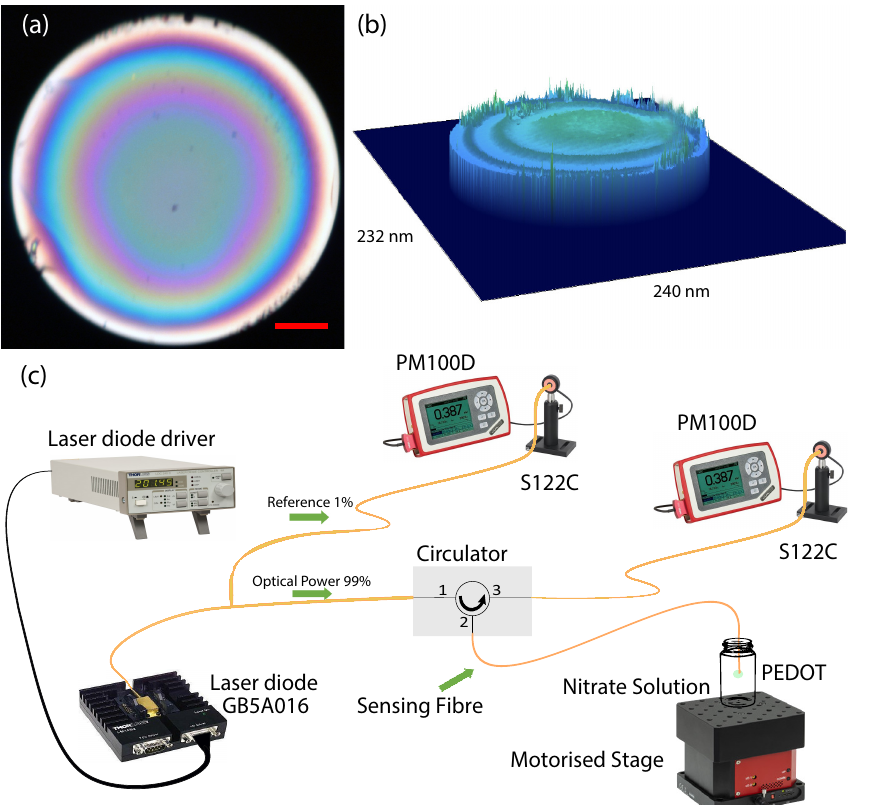
Figure 1. ( a ) Cross-sectional image on reflection mode of PEDOT at the tip of a SMF-28 fibre. Scale bar represent 20 µ m (red line), ( b ) 3D surface profile of PEDOT at the tip of the fibre using confocal profilometry and ( c ) experimental setup for measuring NO − back